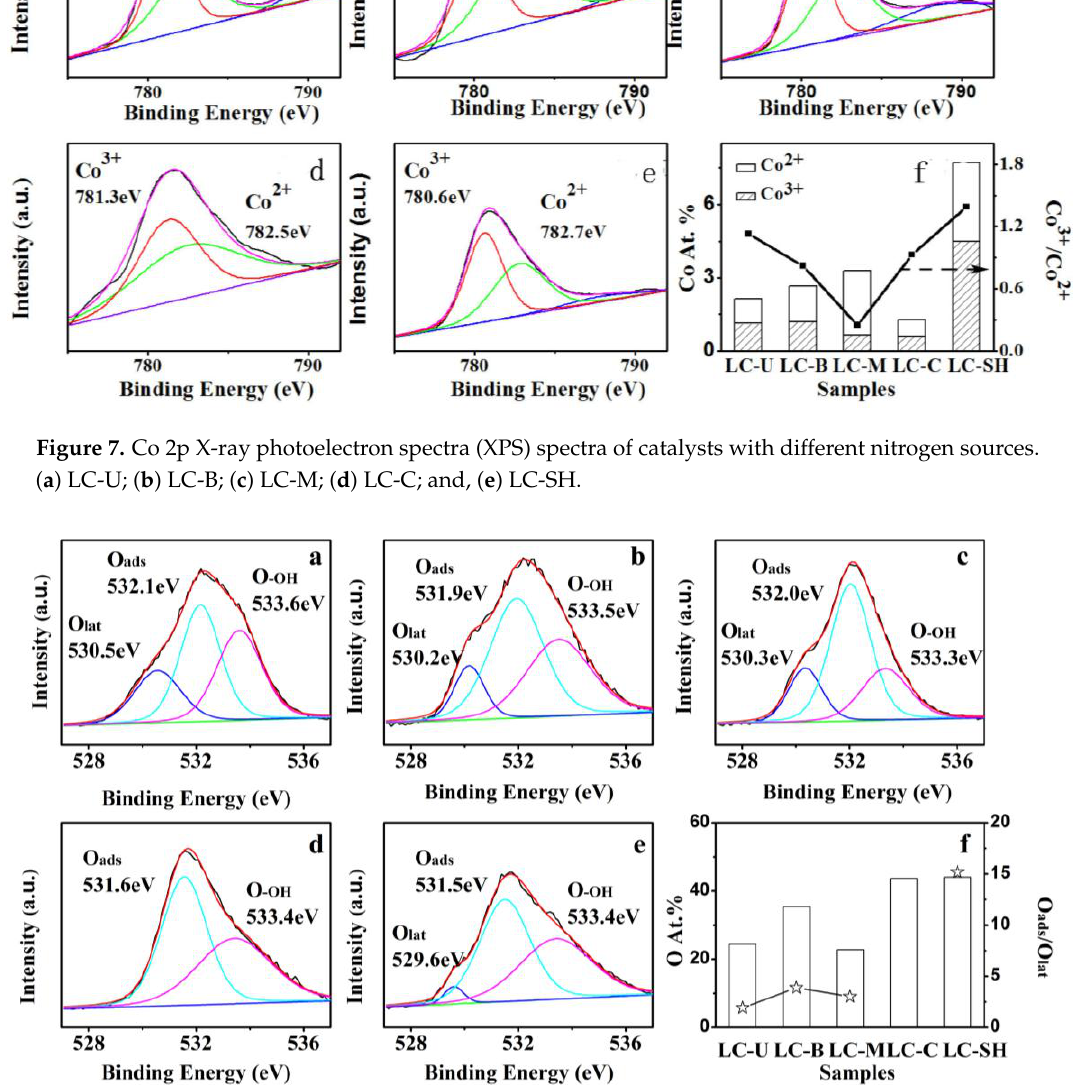
Table 4. Surface atomic concentration of the catalysts with different amounts of nitrogen. Samples